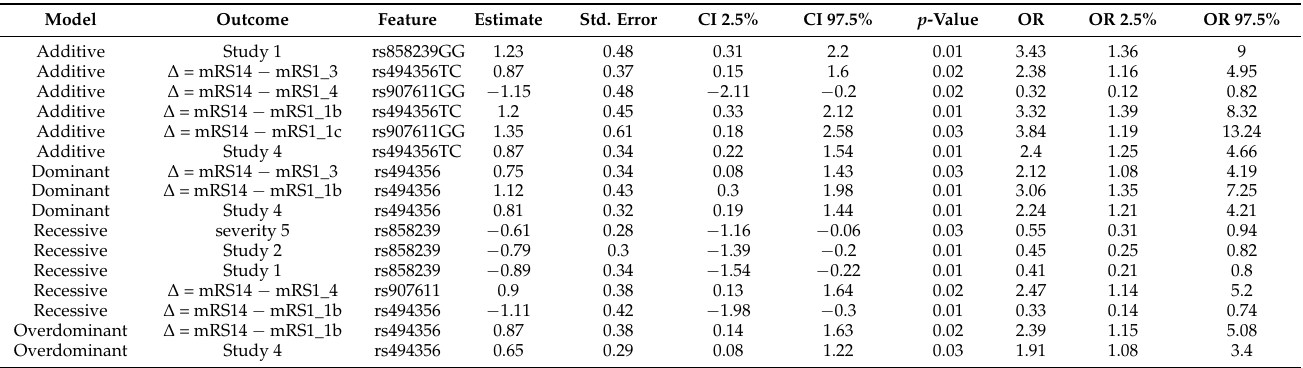
Table 3. SNPs whose genotypes were significantly associated with IS outcome in logistic regres- sion